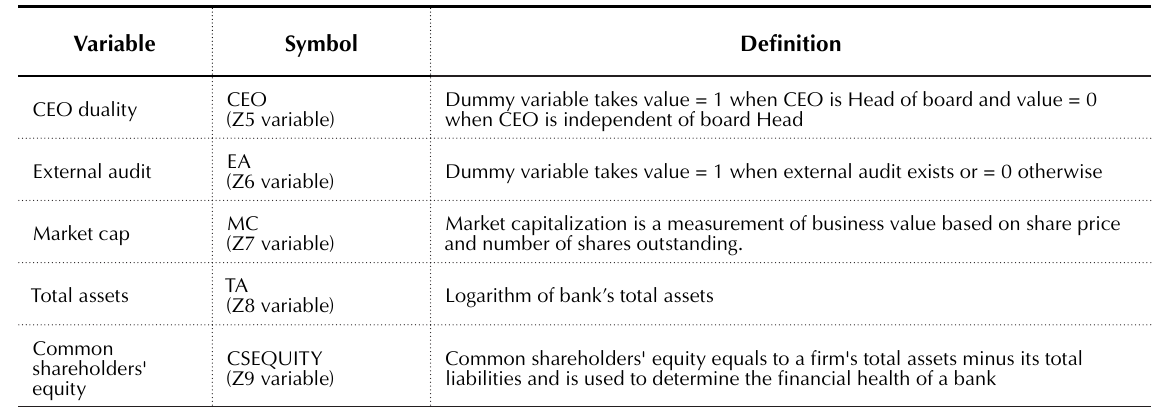
Table 1 (cont). Proposed variable